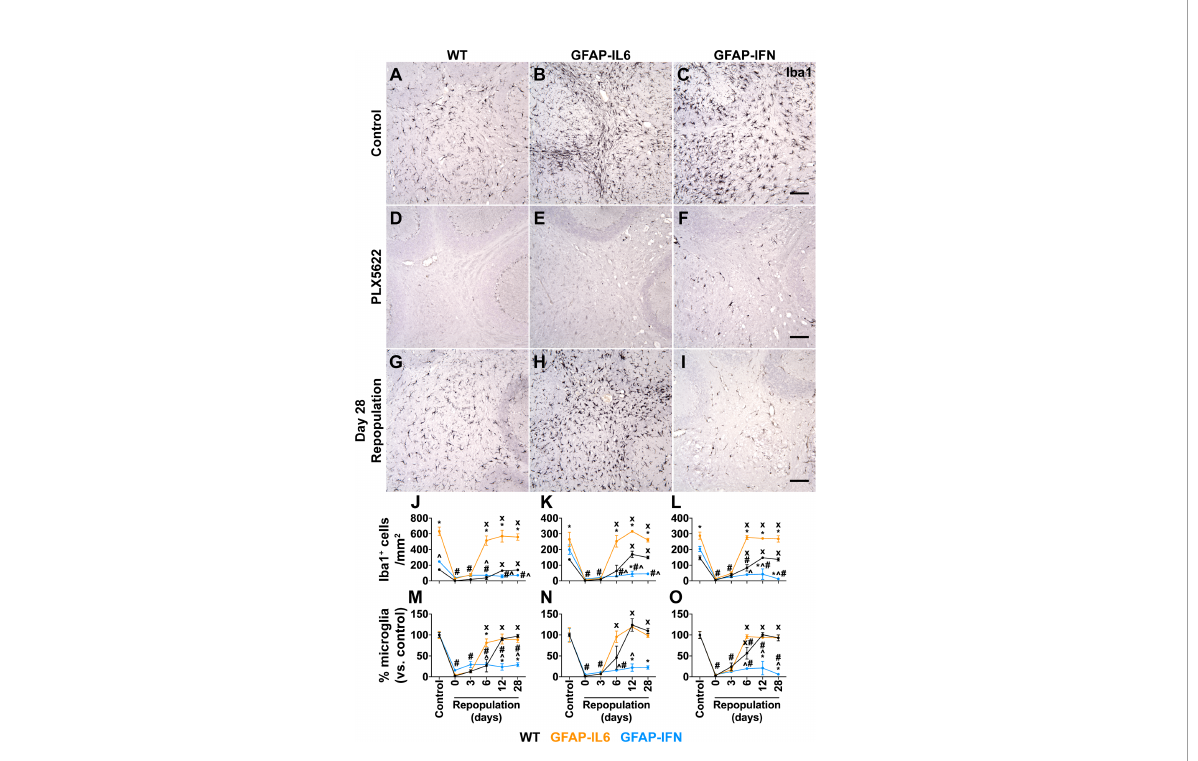
FIGURE 1 Microglia are ablated from the brain of PLX5622-treated mice and have unique repopulation properties in response to IL-6 versus IFN- a . (A – I) Immunohistochemistry for Iba1 performed on brain sections from mice given control or PLX5622 diet at 1-month-old for 14 days, or at different timepoints following removal of PLX5622. Scale bars, 100 m m. Representative images from the cerebellum shown. (J – L) Quanti fi cation of the number of Iba1 + cells in the (J) cerebellum, (K) cortex and (L) hippocampus of mice following withdrawal of PLX5622 for 0, 3, 6, 12 and 28 days. (M – O) Percentage (versus control) of the number of Iba1 + cells in the (M) cerebellum, (N) cortex and (O) hippocampus of mice following withdrawal of PLX5622 for 0, 3, 6, 12 and 28 days. n=3-6 mice/group. For (J – O) , graphs show mean ± SEM. *p<0.05 compared with WT of same diet and timepoint; ^p<0.05 compared with GFAP-IL6 of same diet and timepoint; # p<0.05 compared with untreated control of same genotype; x, p<0.05 compared with PLX5622 day 0 of same genotype using two-way ANOVA with Tukey ’ s